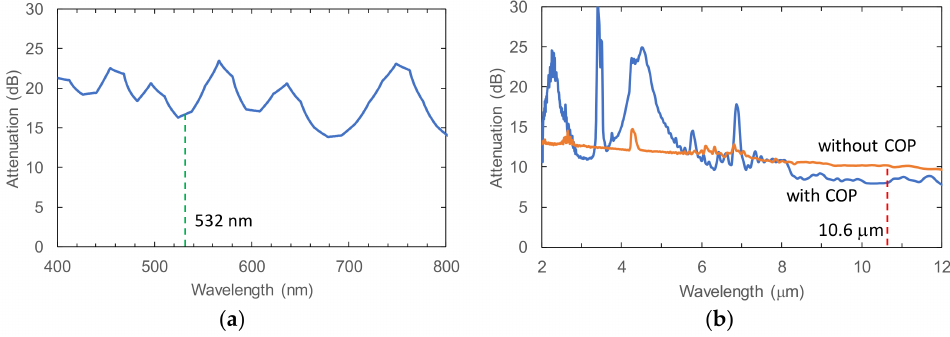
Figure 5. Loss spectra of the COP-coated SUS fibers in ( a ) visible region and ( b ) mid-infrared region.